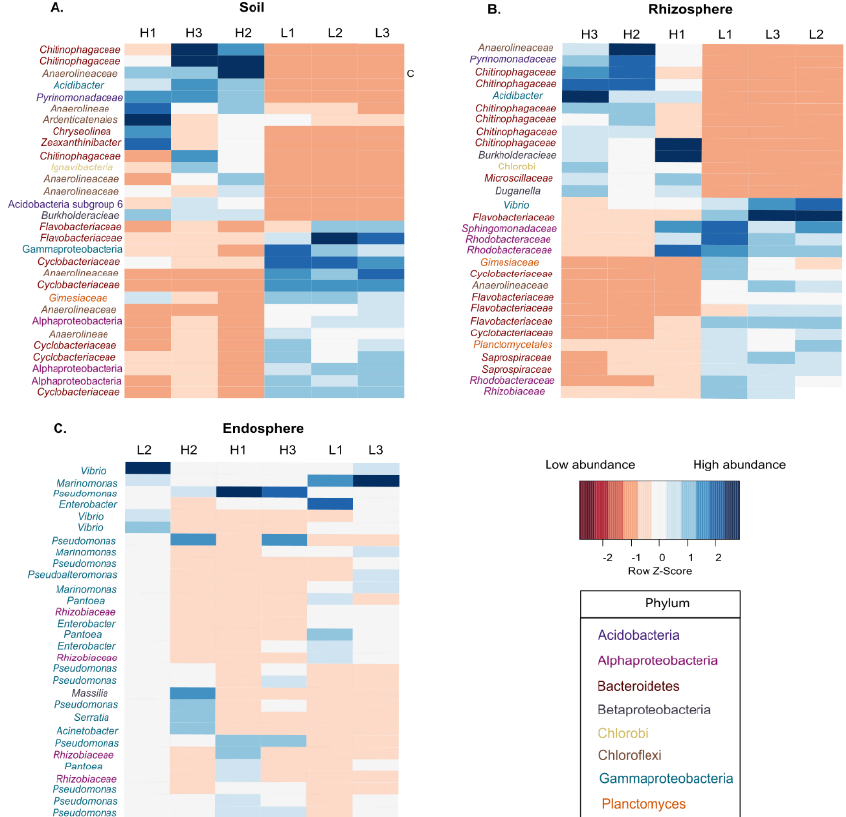
Figure 4. Heat-maps based on pair-wise SIMPER analysis showing the scaled abundances of the first 30 amplicon sequence variants (ASVs) that are primarily responsible for differences in bacterial community composition between high and low elevation in three types of communities: Soil ( A ), Rhizosphere ( B ) and endosphere ( C ). Sites label is located at the top of each column (H = high elevation; L = low elevation). The colors of the taxa names indicate the Phylum to which they belong.